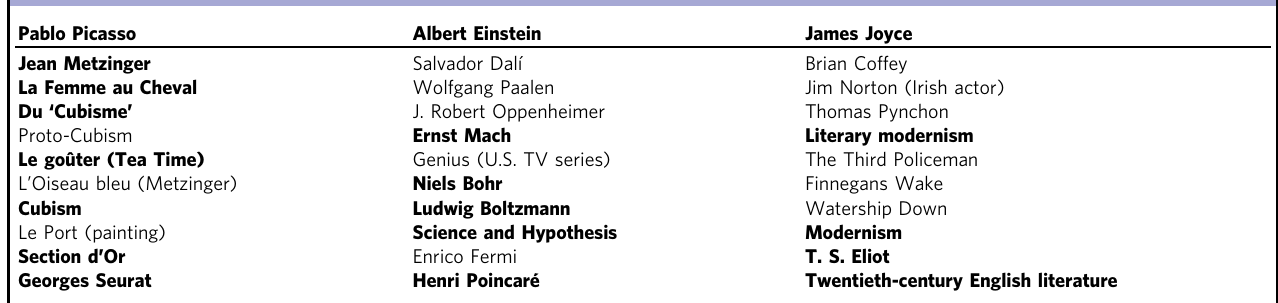
therefore they were neither cited by Miller.